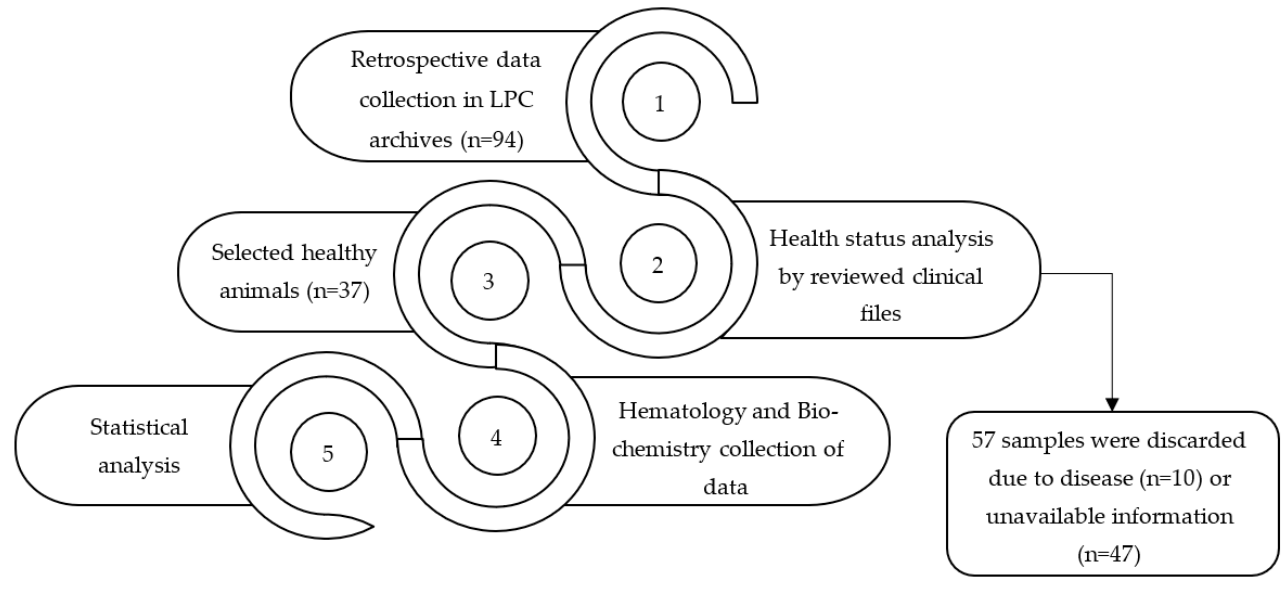
Figure 1. Flowchart of the retrospective analysis of this study.